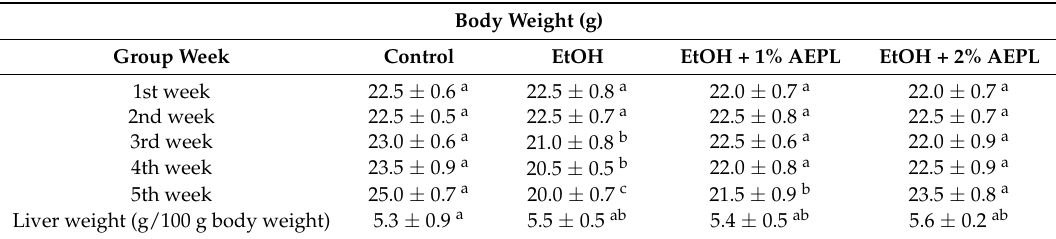
Table 2. Effects of different doses of aqueous extract of pepino leaves (AEPL) on changes in body weight during the 5-week experimental period and liver weight in alcohol-induced liver injury in